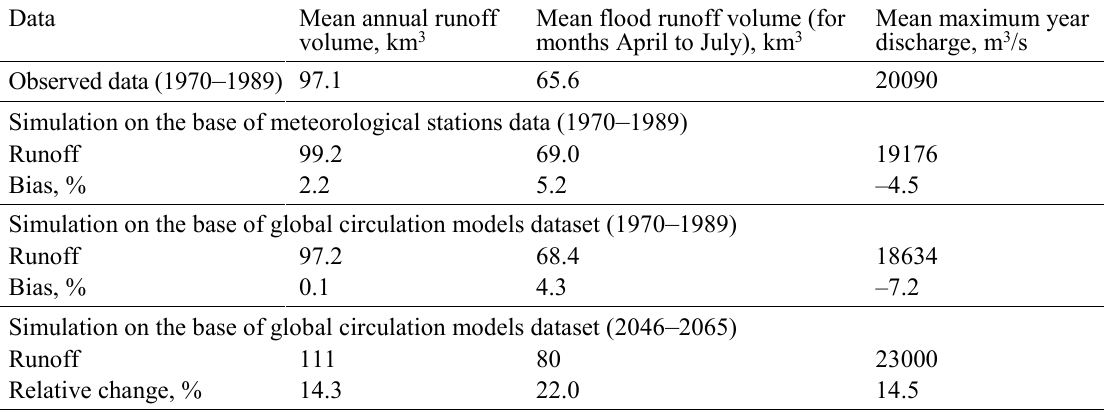
Table 2 The Northern Dvina River runoff characteristics (gauge Ust-Pinega) for the basic period (1970– 1989) and for the future